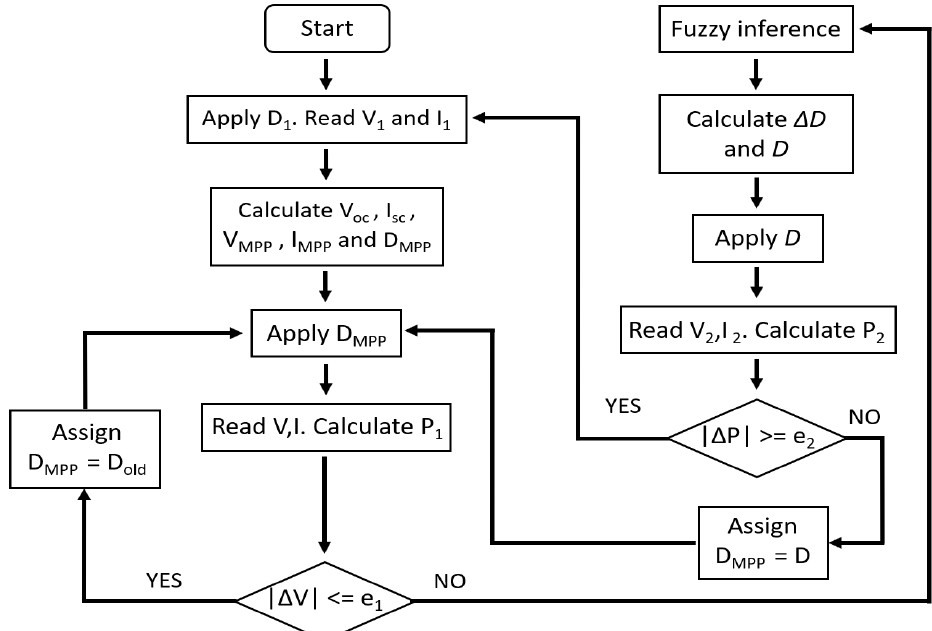
Figure 1. Designed MPPT algorithm flow